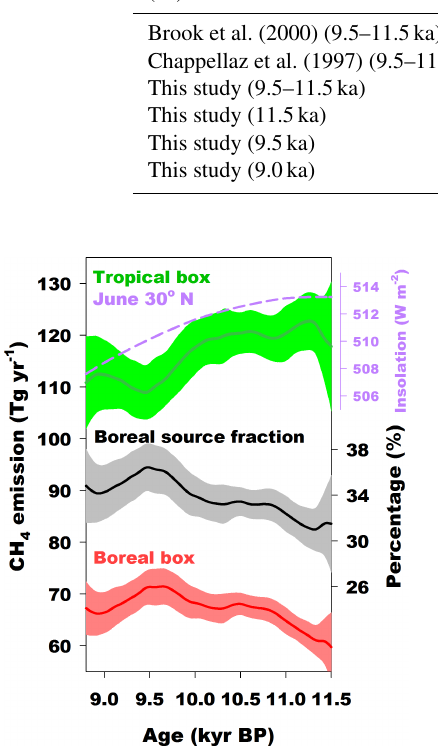
Figure 8. Three-box source distribution model results of tropical (green) and boreal (red) boxes. Black line shows the boreal to total source fraction (see text). Purple dashed line plotted with tropical emission is summer insolation in 30 ◦ N (Berger and Loutre,